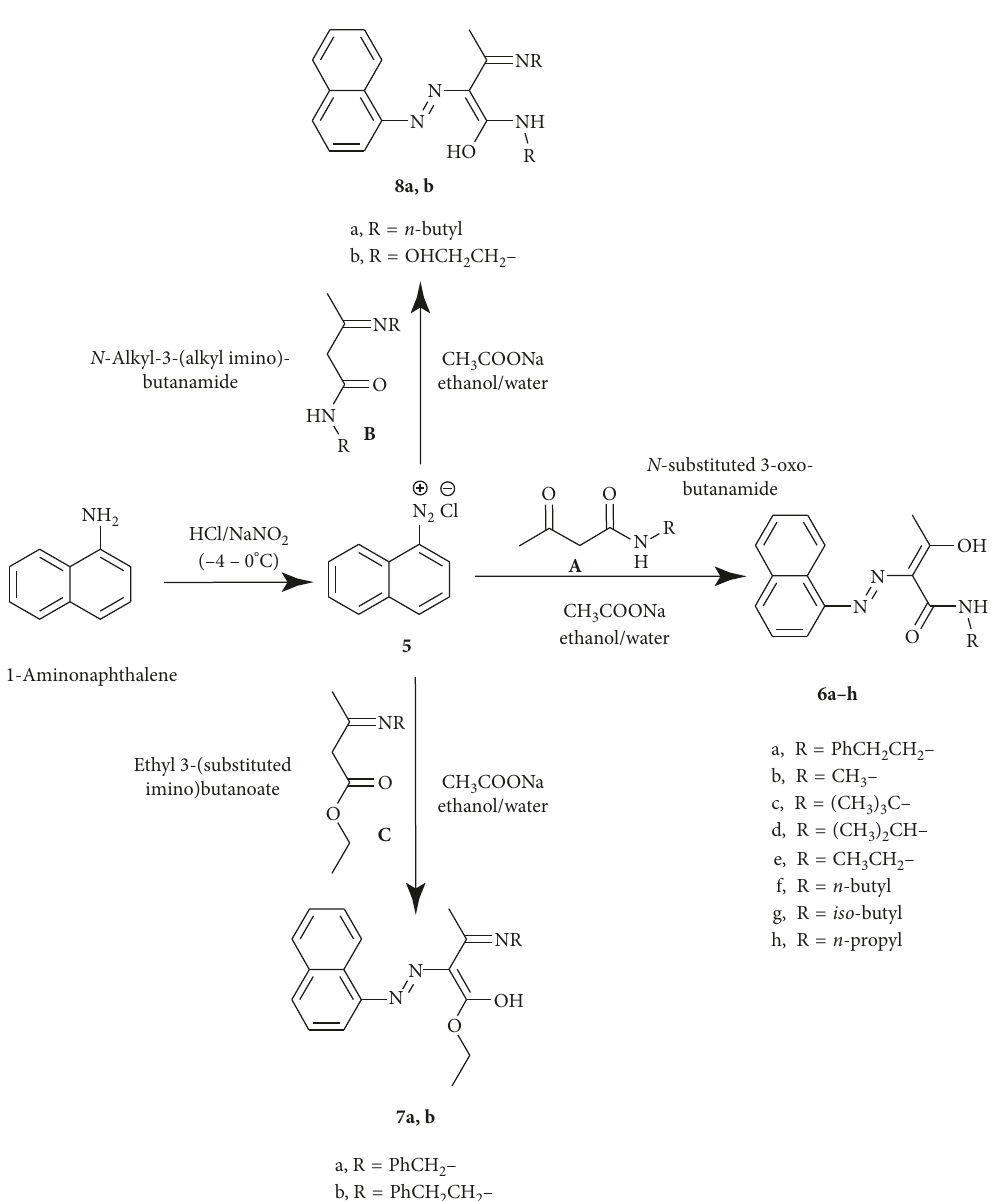
Scheme 2: Synthetic route of compounds 6–8